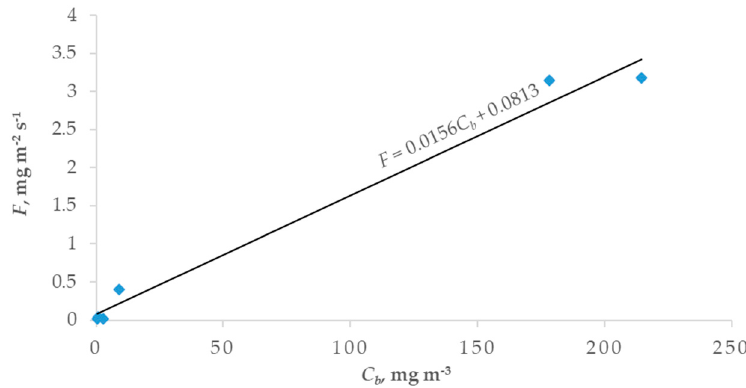
Figure 6. Scatter plot of the initial concentration C b of methane in borehole and the average flux from borehole F : linear relationship and its equation.